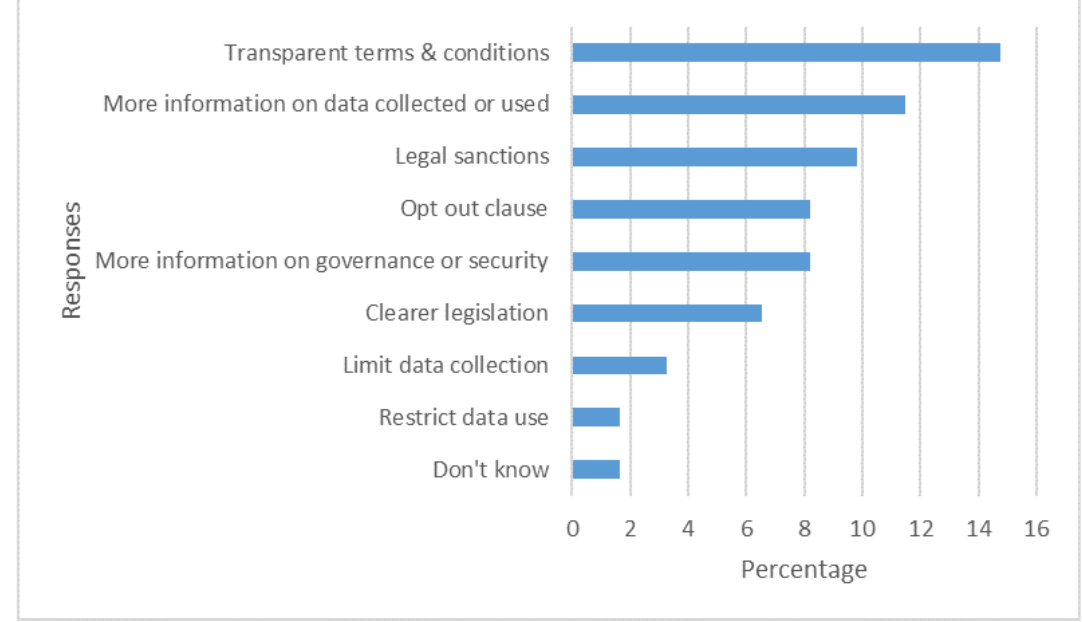
Figure 4. Public views on how to address concerns about mobile phone data